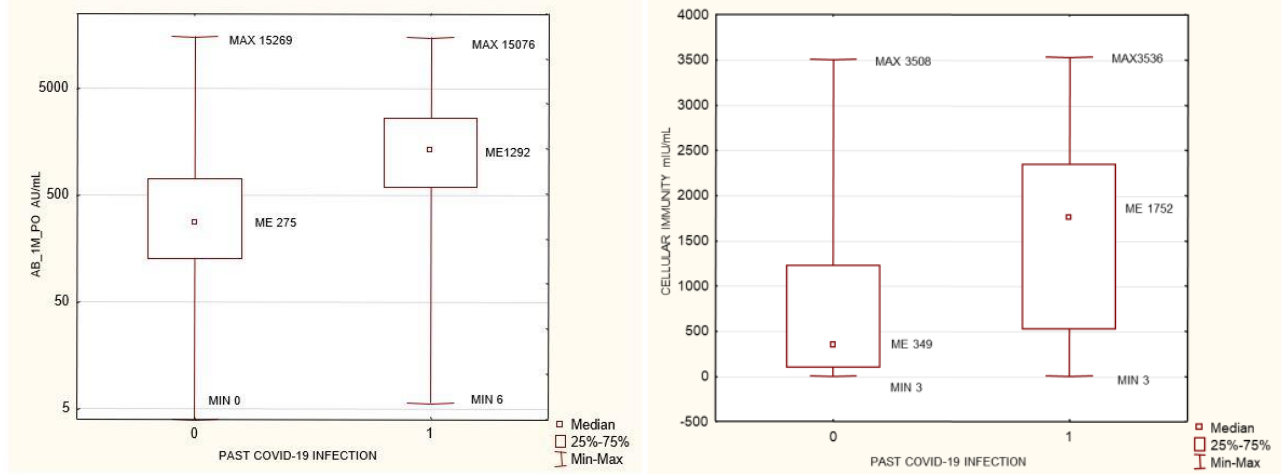
Figure 1. Anti-SARS-CoV-2 antibody levels prior to and after vaccination in groups that developed positive or negative cellular immunity. p = 0.004 and p = 1.77 × 10 –05 , respectively. Mann – Whitney U test. AB_1M_PO- anti SARS-CoV2 antibody level one month after completed vaccination, CELLU- LAR IMMUNITY after completed vaccination: INFγ concentration > 200 mIU/mL positive, <100 mIU/mL negative.